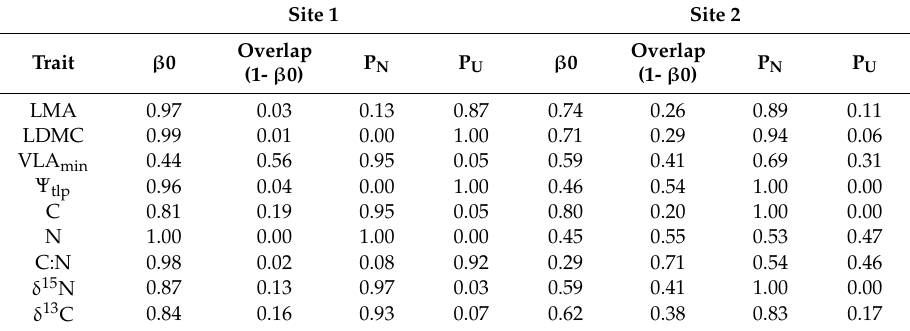
Figure 2. Trait probability density curves (TPDs) for native and invasive assemblage in the two sampling sites. β 0 represents functional dissimilarity and it ranged between 0 and 1 (no functional overlap). Table 2. Functional dissimilarity ( β 0) and overlap between native and invasive assemblages in the two sampling sites for each functional trait (CWM) used in this study. PN and PU represent the relative components of the dissimilarity, which is exclusive or joint between the two distributions, respectively. See Table 1 for the full list of abbreviations of the measured